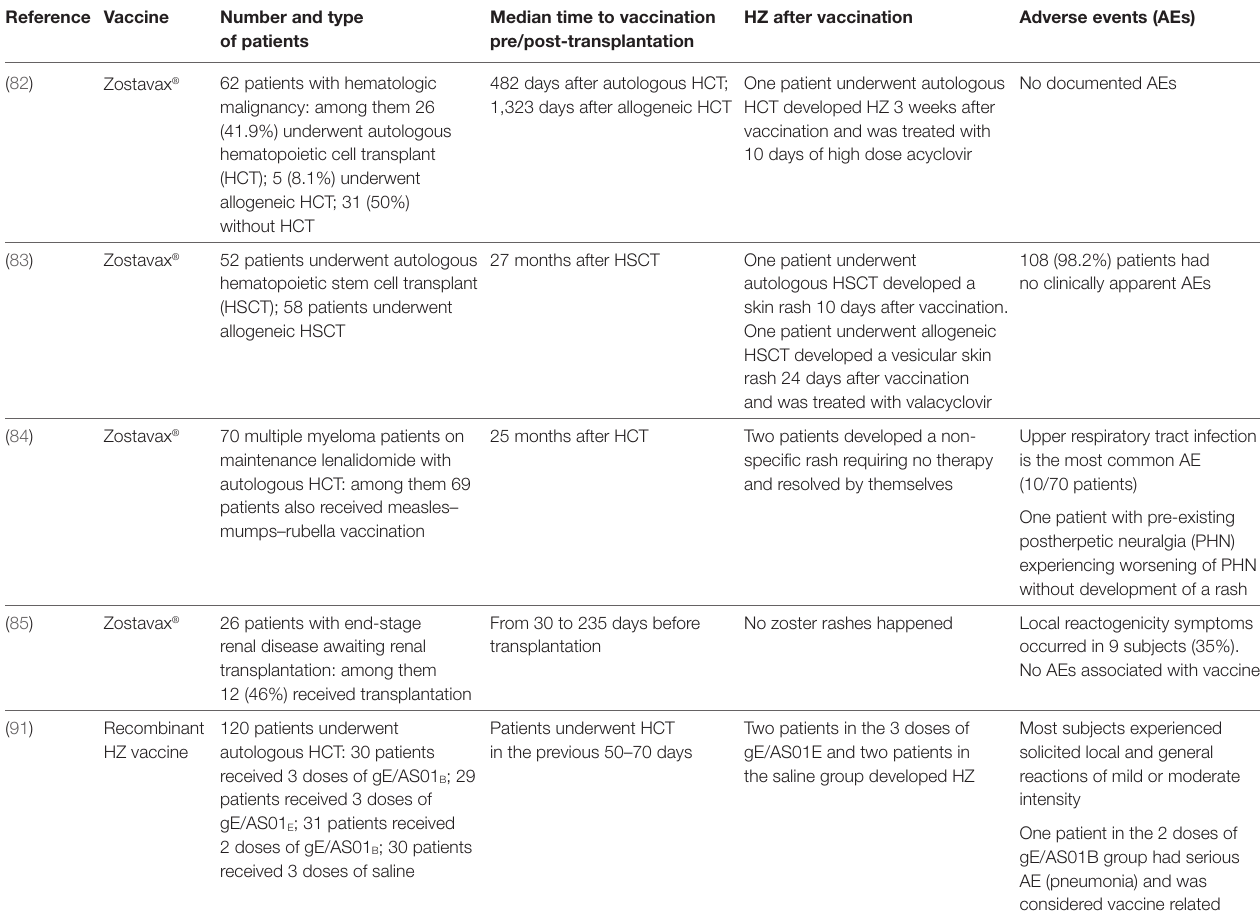
TAbLe 2 | Herpes zoster (HZ) vaccine usage in transplant